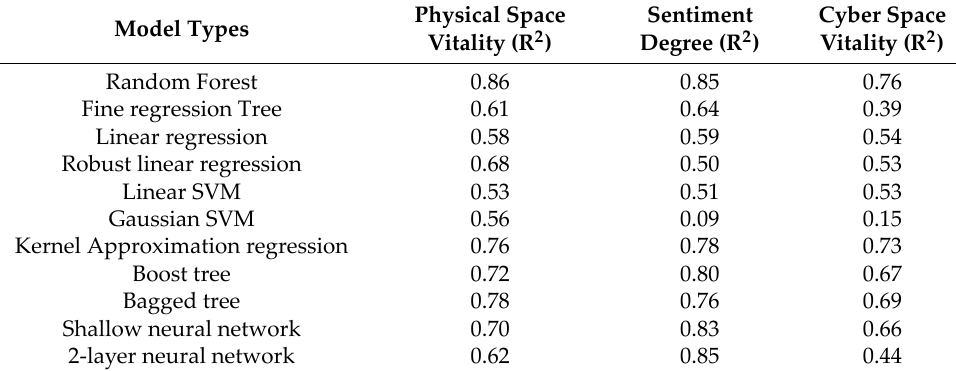
Table A1. Performance of models based on other algorithms.